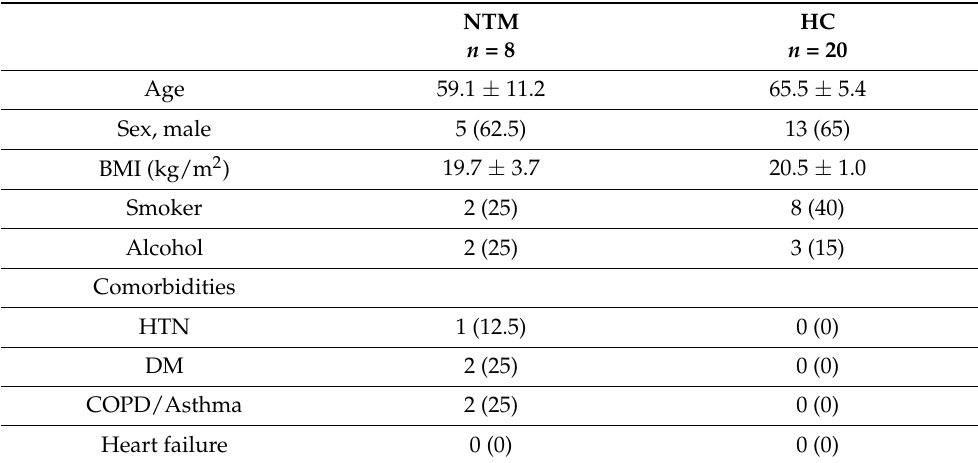
Table 1. Baseline characteristics of patients with NTM and healthy